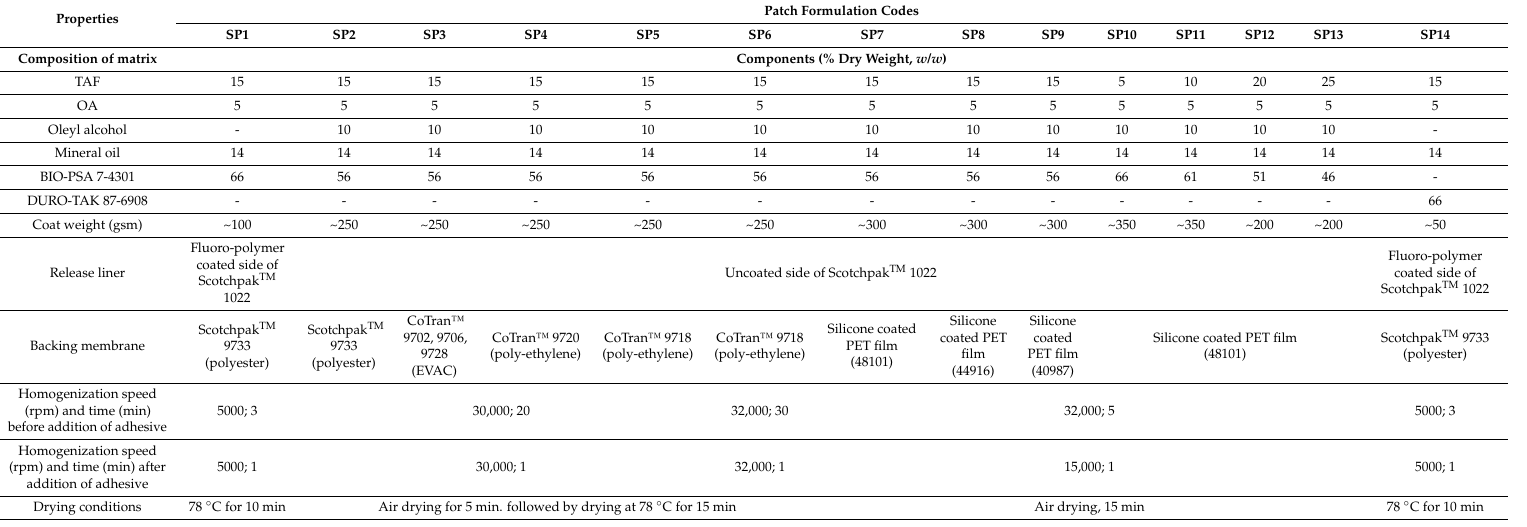
Table 2. Composition and manufacturing parameters of the silicone based TAF suspension transdermal